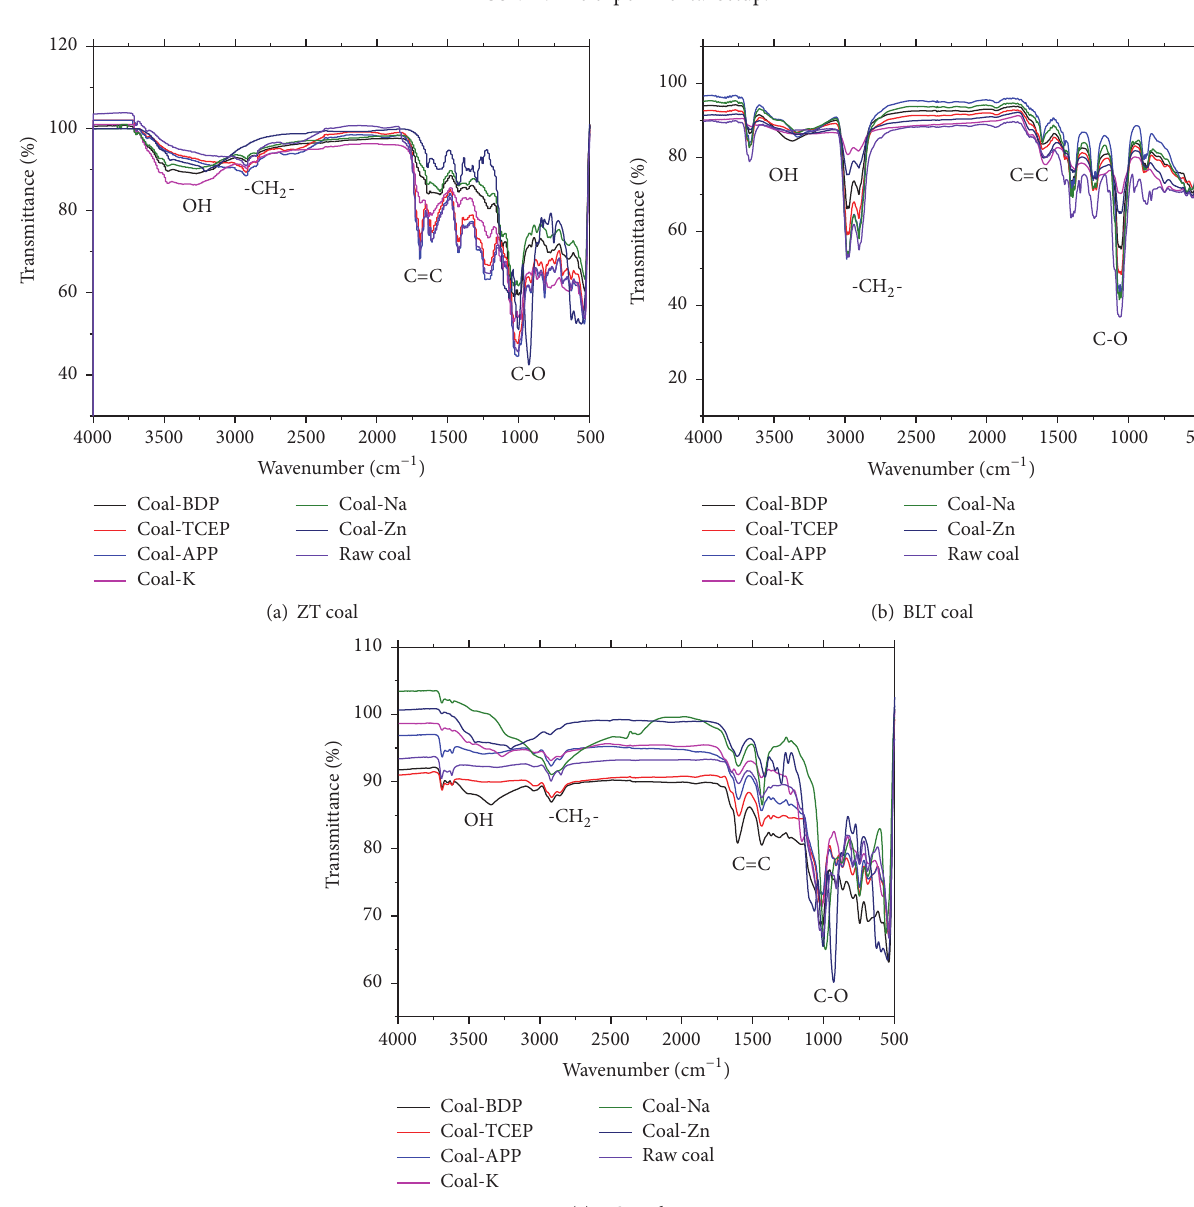
Figure 2: The FTIR of coal samples before and after